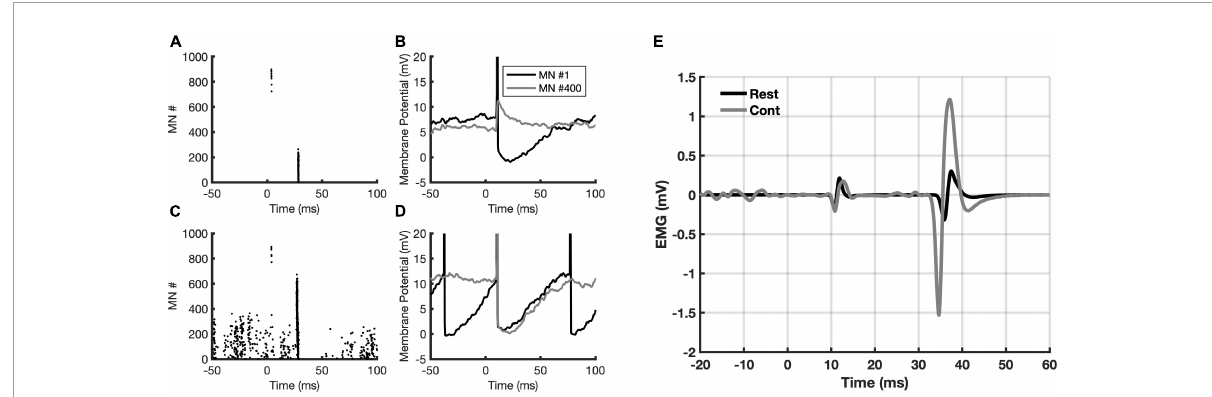
FIGURE4 Data from the simulations. (A) Recruited motoneurons (MNs) from the stimulation to the posterior tibial nerve; (B) the membrane potential from two MNs (#1 and #400) in response to stimulation; (C) the same as in panel A, but now with a descending drive at 15% MVC.; (D) the same as in panel (B) , but now with a descending drive at 15% MVC; (E) simulated M-wave and H-reflex at rest (black sweep) and during 15% MVC contraction (gray sweep). Note the EMGb in the gray sweep. The zero in the abscissa indicates the moment when the stimulus is